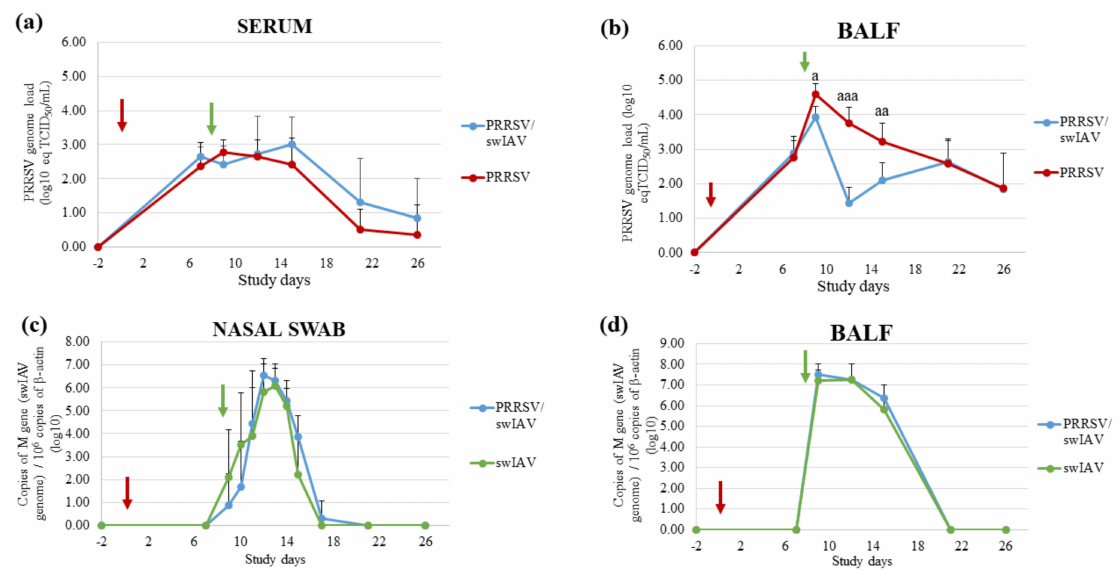
Figure 2. PRRSV or swIAV genomic load in sera, BALF and nasal swab supernatants from inoculated groups. PRRSV genomic loads quantified in sera ( a ) and BALF ( b ). swIAV genomic loads quantified in nasal swab supernatants ( c ) and BALF ( d ). All data are reported as the mean ( ± standard deviation) of results obtained from pigs ( n = 6) in the PRRSV/swIAV group (blue), PRRSV group (red), swIAV group (green). a: p < 0.05; aa: p < 0.01; aaa: p < 0.001. SD0 (red arrow): PRRSV inoculation; SD8 (green arrow): swIAV inoculation. Table 3. Mean PRRSV infectious titers (log10 TCID 50 /mL) ( ± standard deviation) measured from SD7 to SD21 in BALF from PRRSV/swIAV and PRRSV groups.